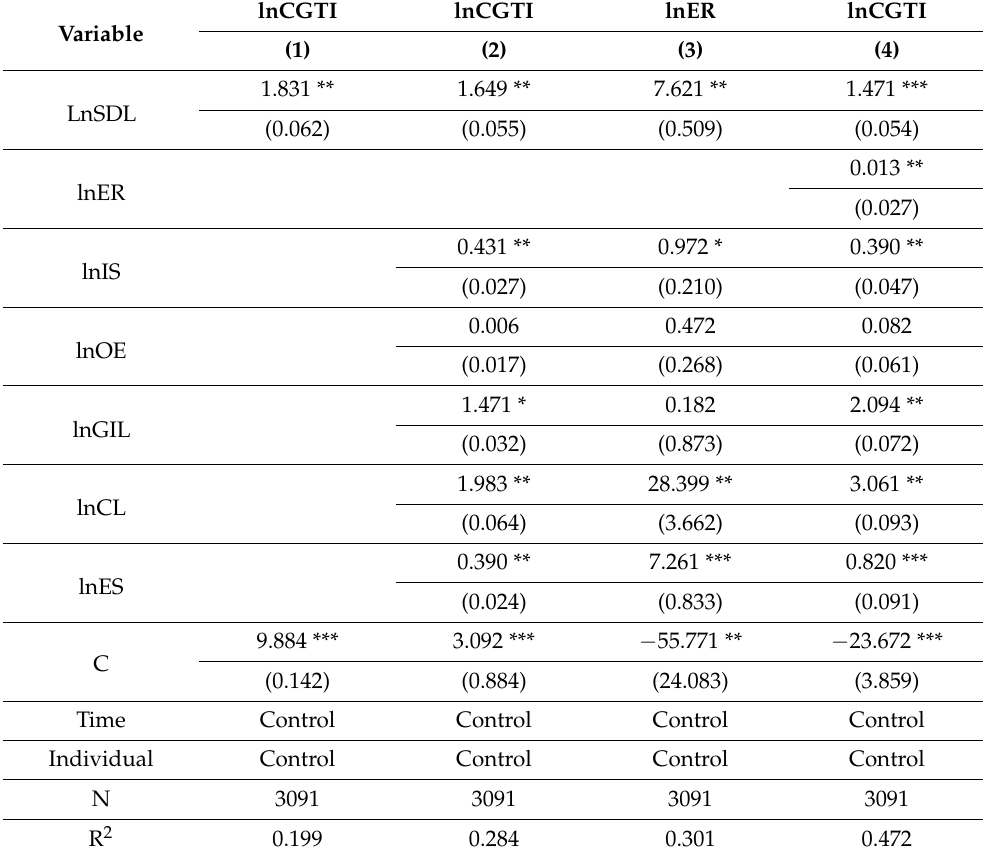
Table 3. Regression results of the impact of the digital economy on CGTI.